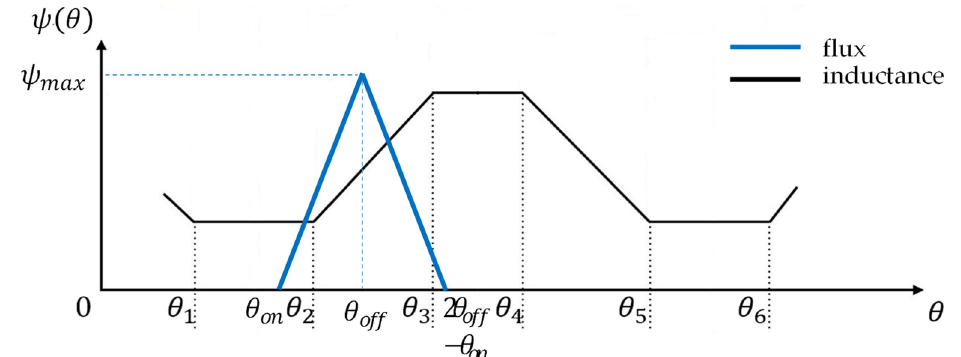
Figure 2. Flux linkage curve of linear model.